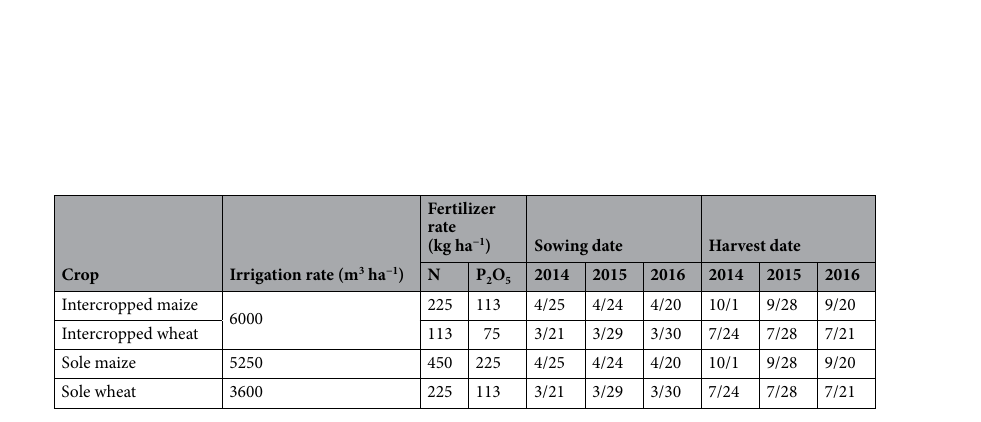
Figure 6. Layout of wheat–maize intercropping pattern and the field locations of the geothermometer and respiratory base in each study year.